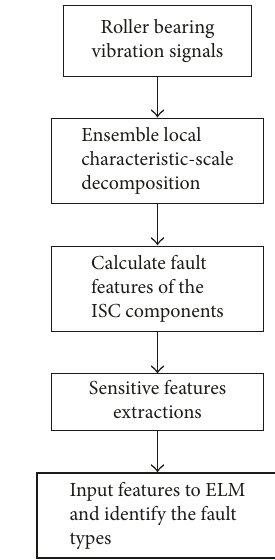
Figure 5: Flow chart of fault diagnosis using ELCD and